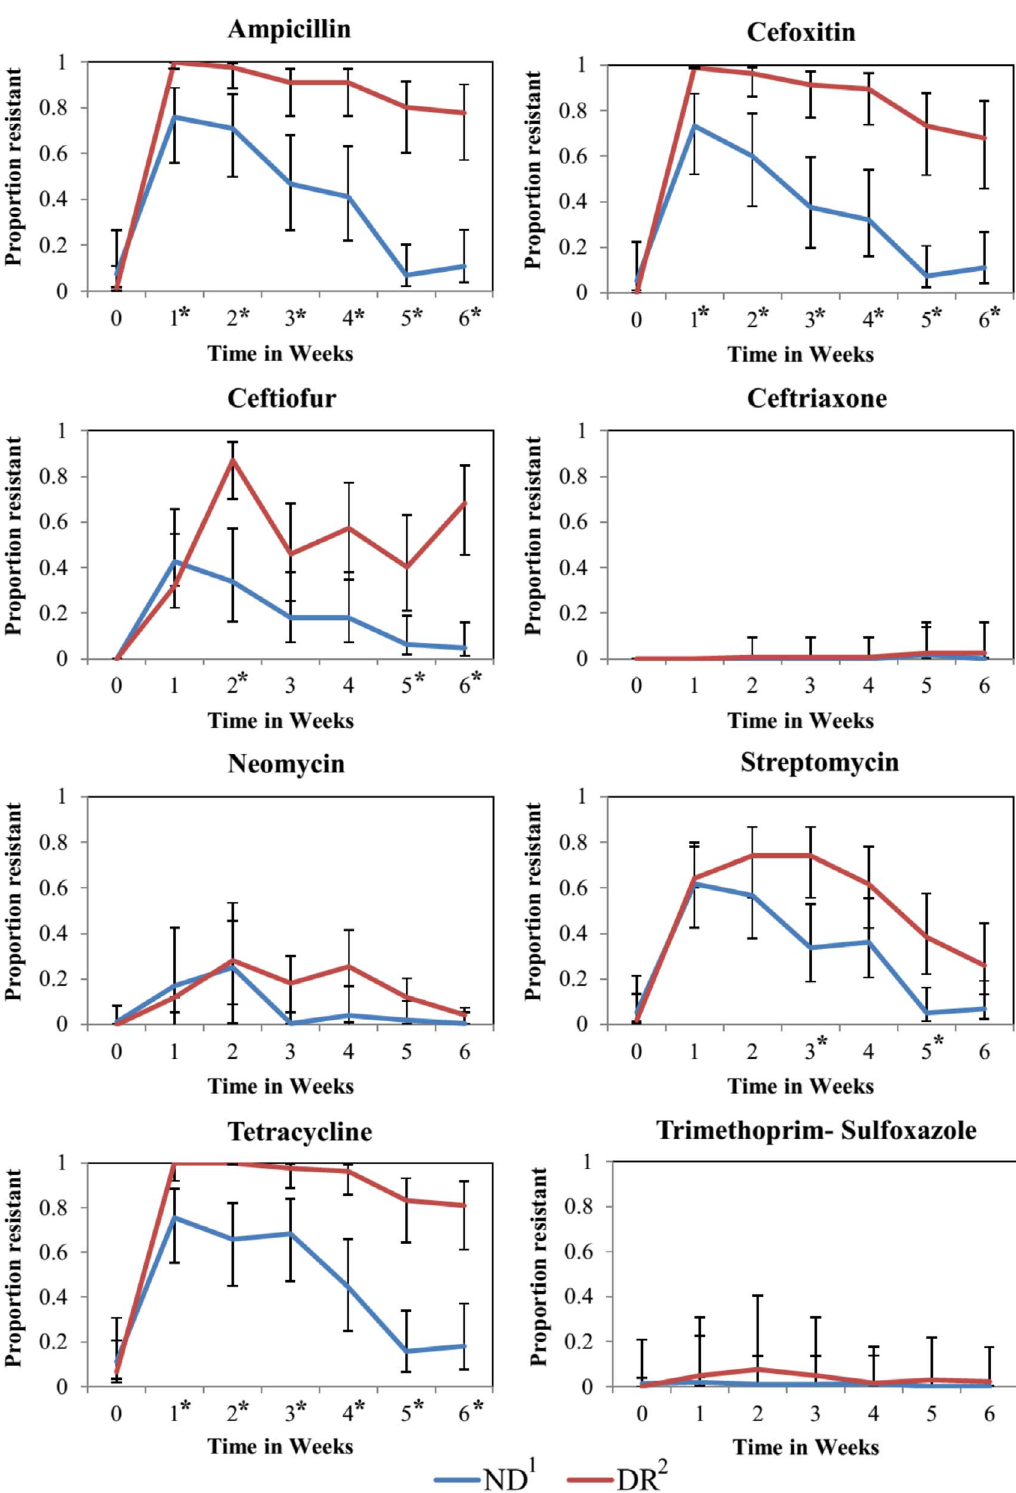
Fig. 2. Proportion of resistant E. coli by milk feeding treatment at the calf level over time in weeks. Error bars represent 95% confidence interval of the least square mean. 1. Calves fed raw milk without the addition of sub-MICs of antimicrobial drugs. 2. Calves fed raw milk with the addition of sub-MICs of